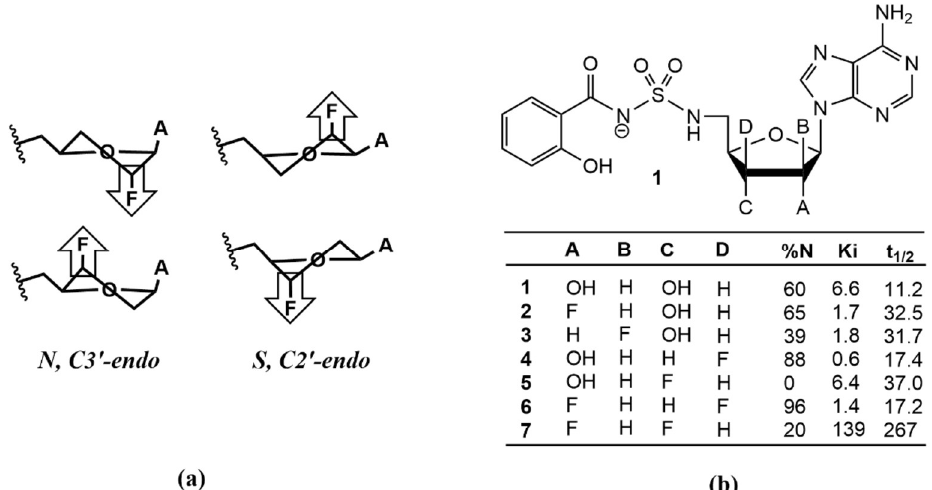
Figure 1. Pucker profile of fluorinated sugars: ( a ) influence of fluorine on ring conformation. The ring pucker is pulled to the side of the most electronegative atom due to the gauche effect; ( b ) ring conformation, enzyme binding, and half-life of fluorinated Sal-AMS derivatives reported in [9].